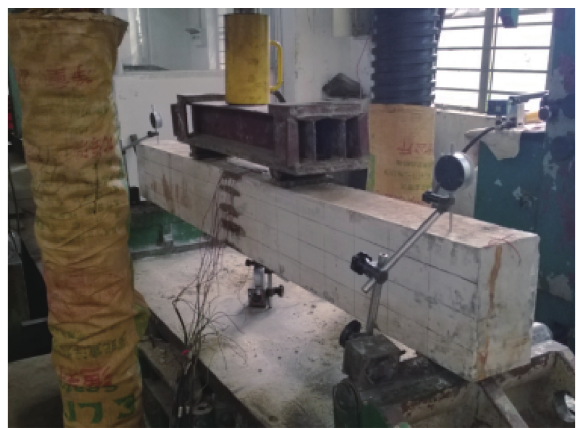
Figure 9: Loading picture of test beam.